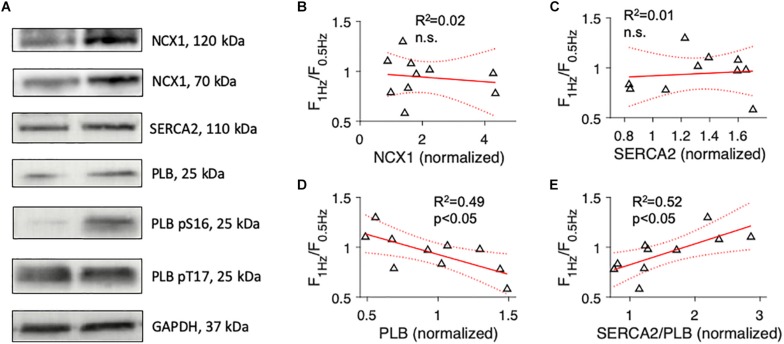
Association of the force-frequency relationship with expression levels of proteins involved in cardiomyocyte Ca2+ cycling. (A) Example images of Western blots of cardiac sodium-calcium exchanger (NCX1), cardiac sarco/endoplasmic reticulum Ca2+-ATPase (SERCA2), total phospholamban (PLB), phospho-S16 (pS16) PLB, phospho-T17 (pT17) PLB, and glyceraldehyde 3-phosphate dehydrogenase (GAPDH). (B) Linear model showing the correlation of force at 1 Hz relative to force at 0.5 Hz pacing rate (F1Hz/F0.5Hz) with NCX1 protein expression (normalized to a reference sample). R2 is the coefficient of determination, p indicates the probability of type I error of linear regression. Dotted lines indicate 95% confidence intervals. (C) Correlation of F1Hz/F0.5Hz with SERCA2 protein expression. (D) Correlation of F1Hz/F0.5Hz with total PLB protein expression. (E) Correlation of F1Hz/F0.5Hz with the ratio of SERCA2 to total PLB.